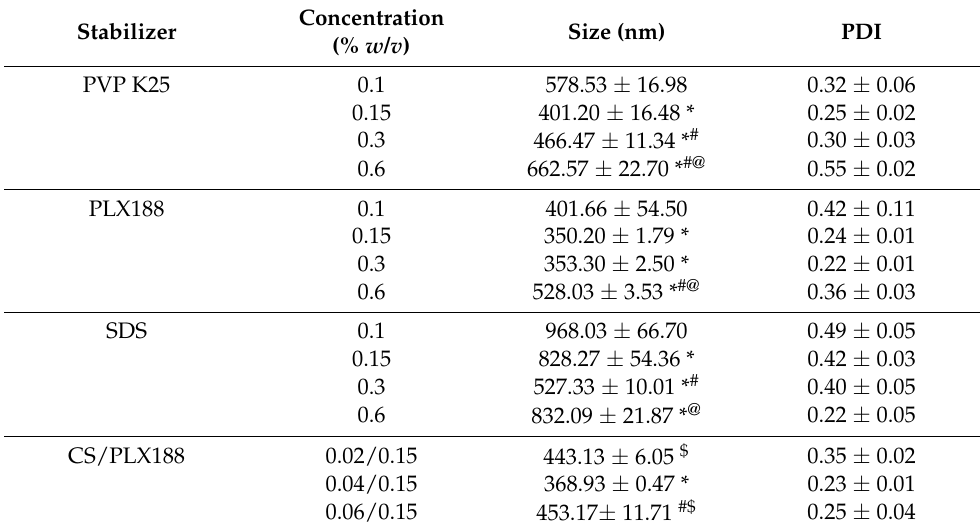
Table 1. Particle size analysis of the prepared NC dispersions.